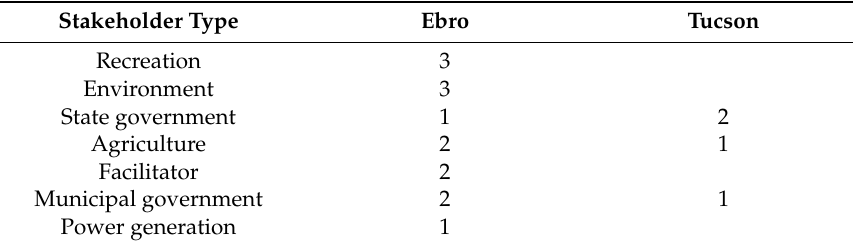
Table 5. Interviewees profile in Ebro and Tucson